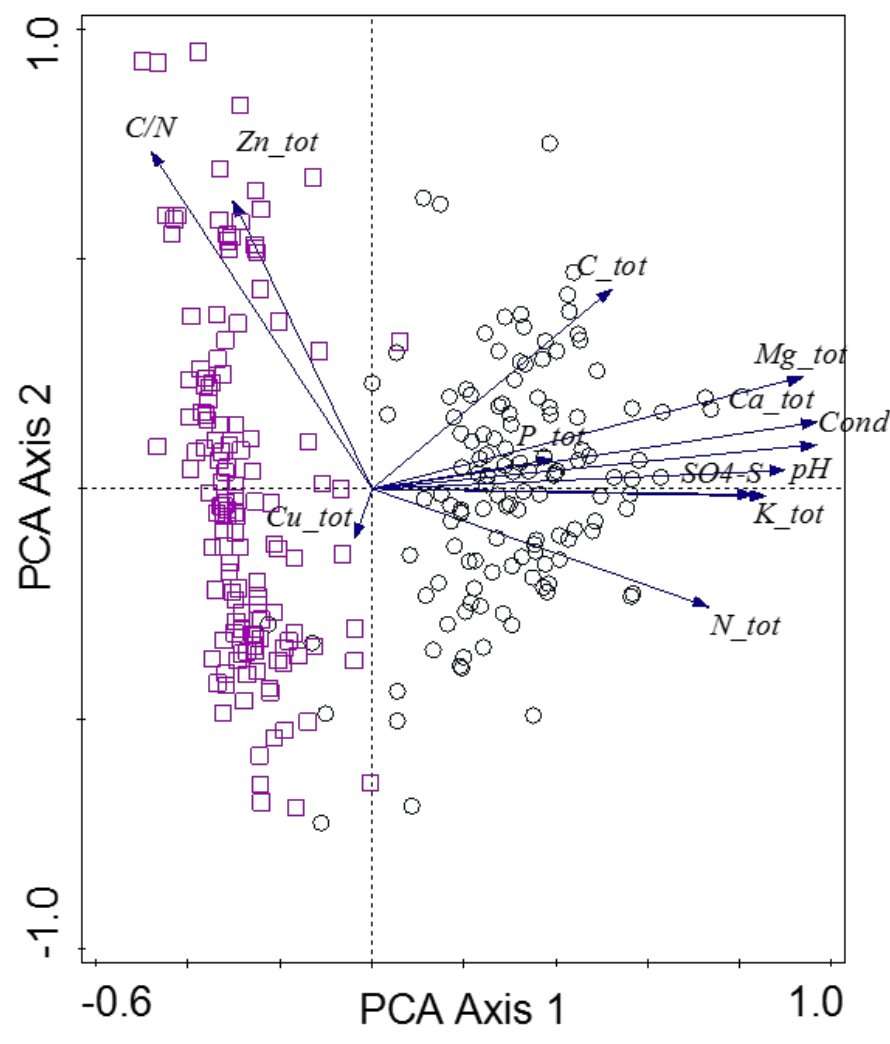
Figure 6. Principal Components Analysis (PCA) of 131 samples of surface water from Västkärr (circles) and 135 samples of surface water from Porla (squares). Axis 1 and Axis 2 explain 63.06 % of total variation. Arrows show the directions of environmental gradients. Surface water sample characteristics used in the analysis were: pH ( pH ), electrical conductivity ( Cond ), concentration of sulphate anion as sulphur equivalent ( SO4-S ), total carbon/total nitrogen quotient ( C/N ), total concentration of calcium ( Ca_tot ), magnesium ( Mg_tot ), potassium ( K_tot ), zinc ( Zn_tot ), copper ( Cu_tot ), phosphorus ( P_tot ), carbon ( C_tot ) and nitrogen ( N_tot